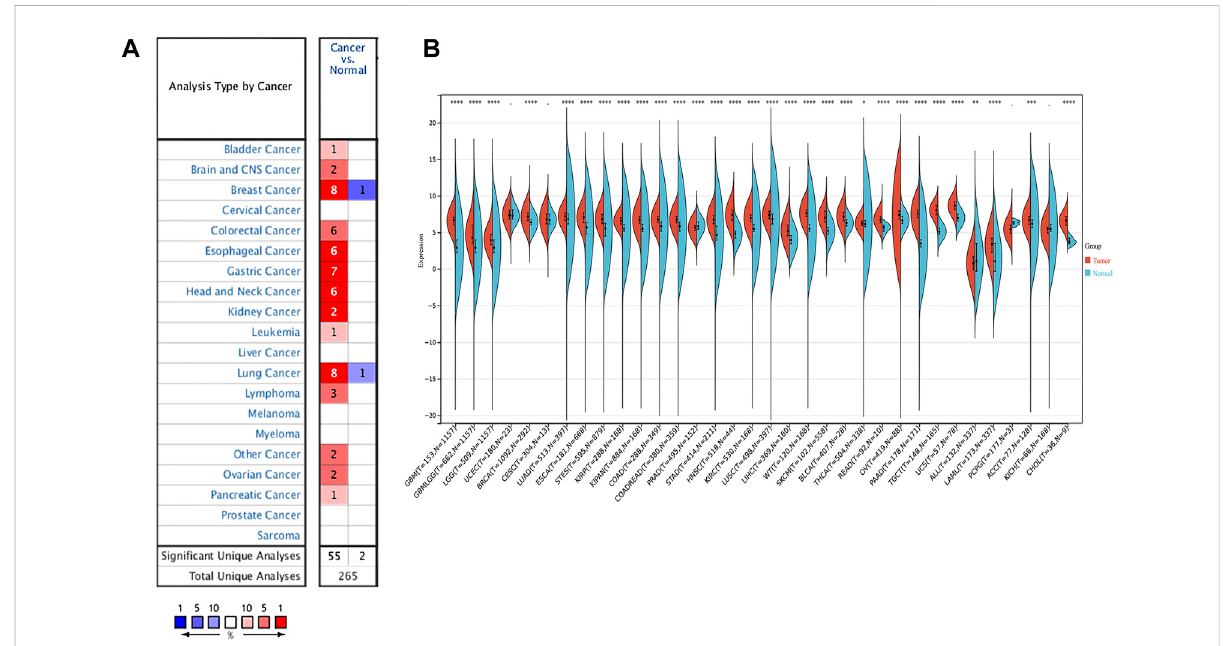
FIGURE 1 SERPINH1 expression analysis in pan-cancer. (A) Expression of SERPINH1 in different cancers and matched normal tissues in Oncomine. The number in each cell is the number of datasets. The red (blue) 1% represents the top 1% of genes that are highly (lowly) expressed in the tumor in the GEO database.Blanks represent data sets that are not inthetop 10% ofhigh orlow tumor expression. (B) Expression of SERPINH1 in differentcancer types in the GTEx and TCGA